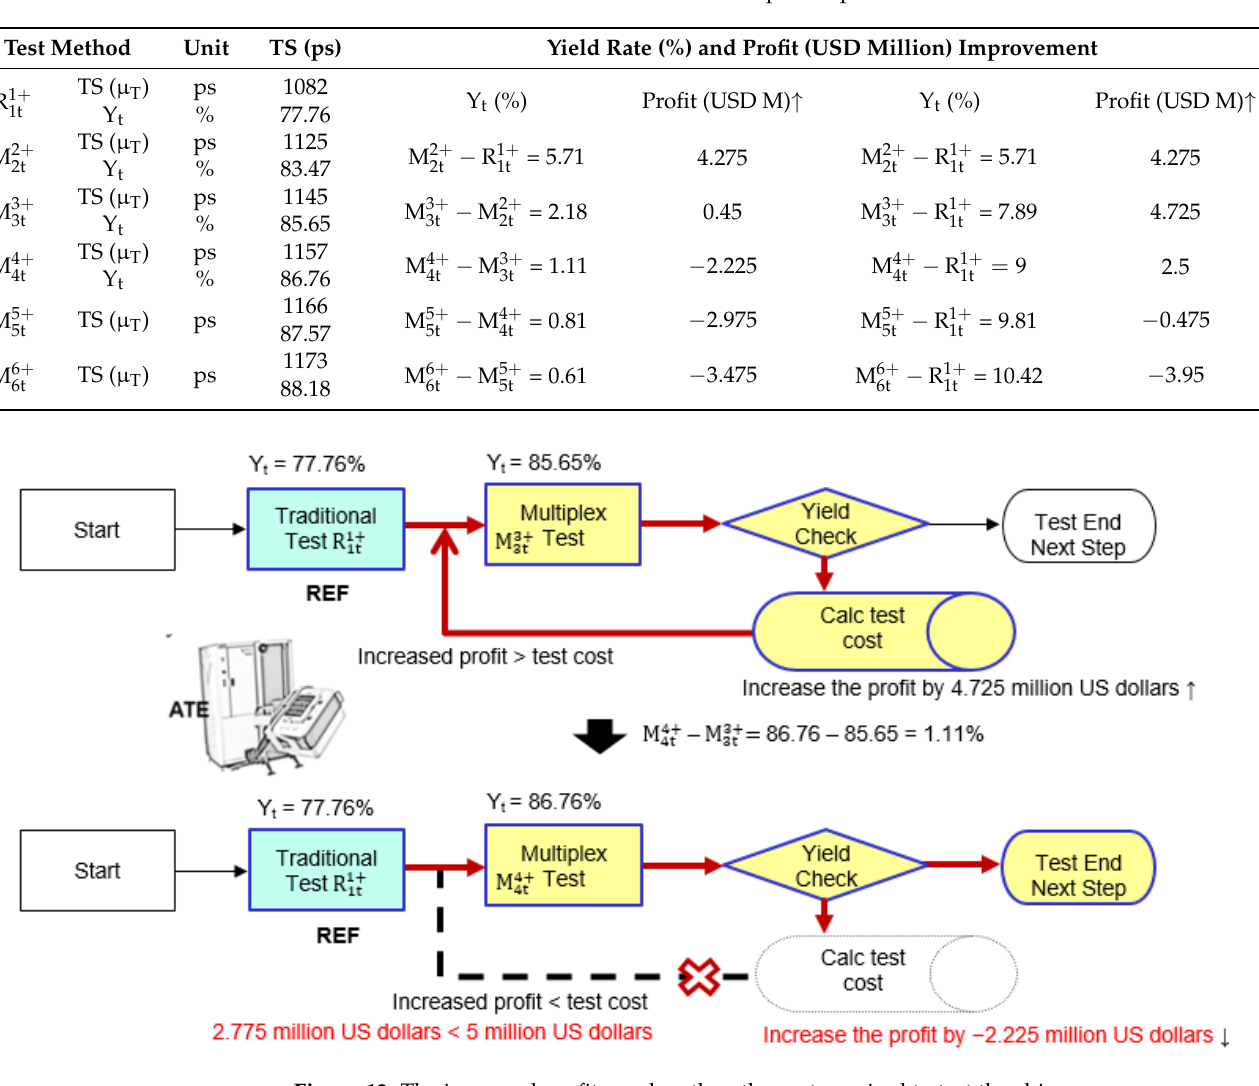
Table 4. The number of tests determines the surplus of